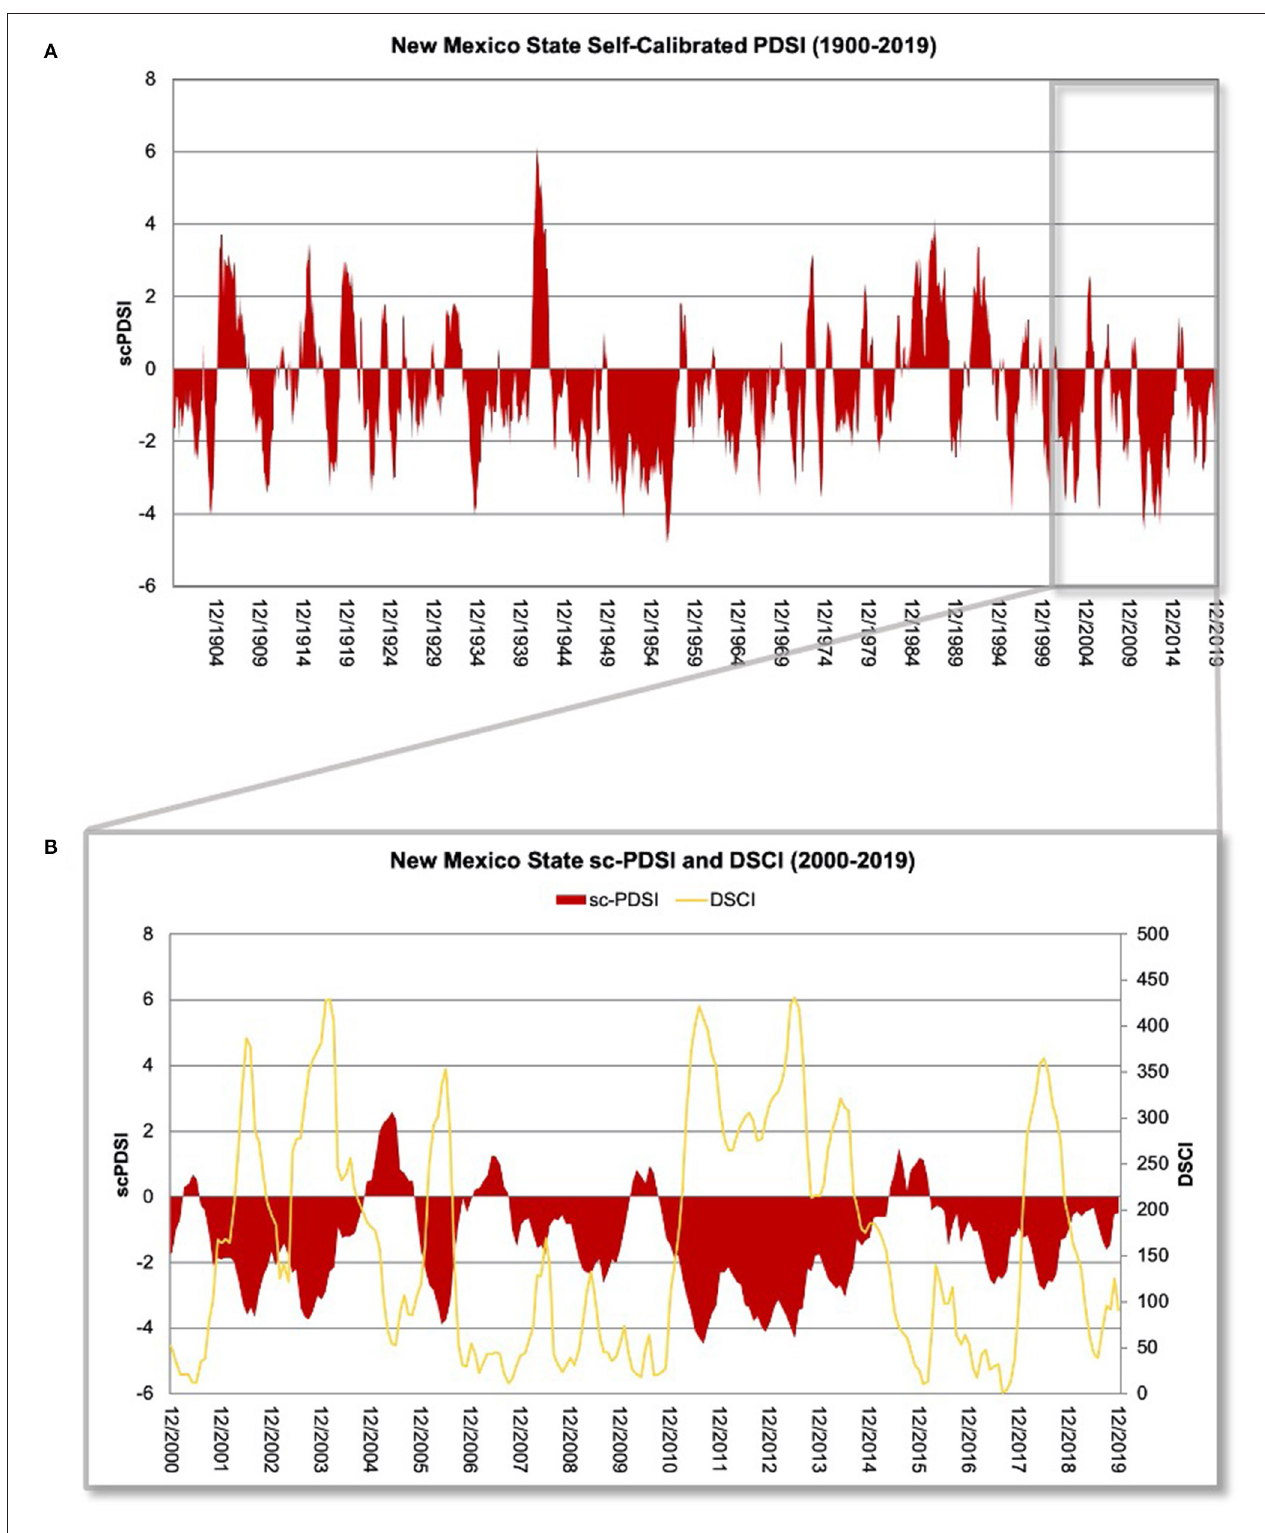
FIGURE 7 | (A) The Self-Calibrating PDSI (sc-PDSC) for the 1900–2019 period and (B) a comparison between the sc-PDSI and the DSCI ( r = 0.76) for the 2000–2019 period over New Mexico.